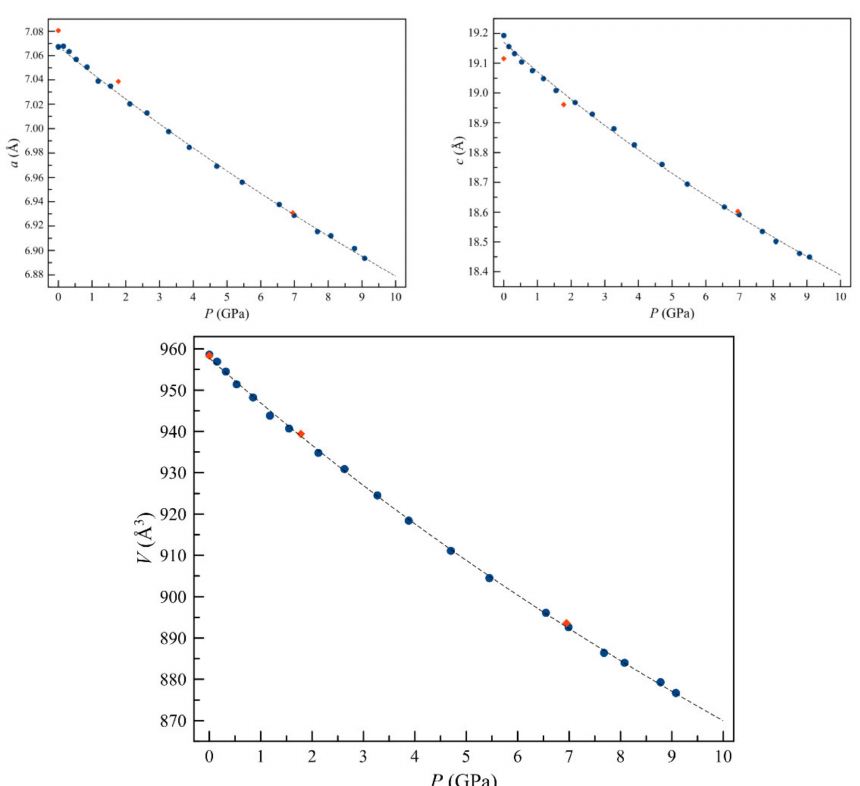
Figure 2. Evolution of the unit-cell parameters of wardite with P . Red diamonds: data collected in decompression. Dashed lines represent the Equation of State (EoS) fits (see text for details). Error bars are smaller than symbols.